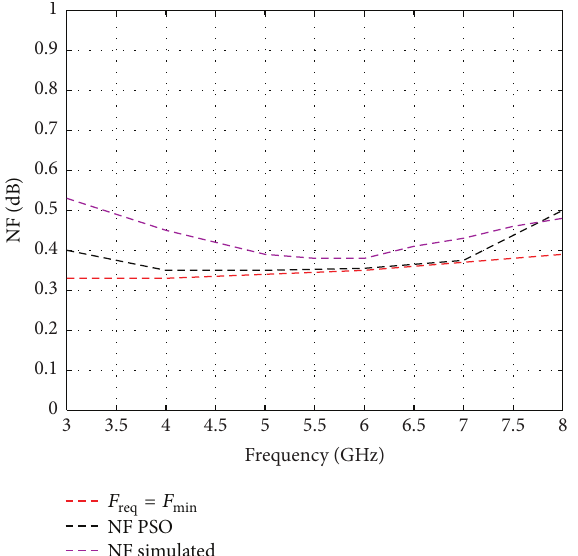
Figure 13: Comparative results for noise figure of designed ampli-